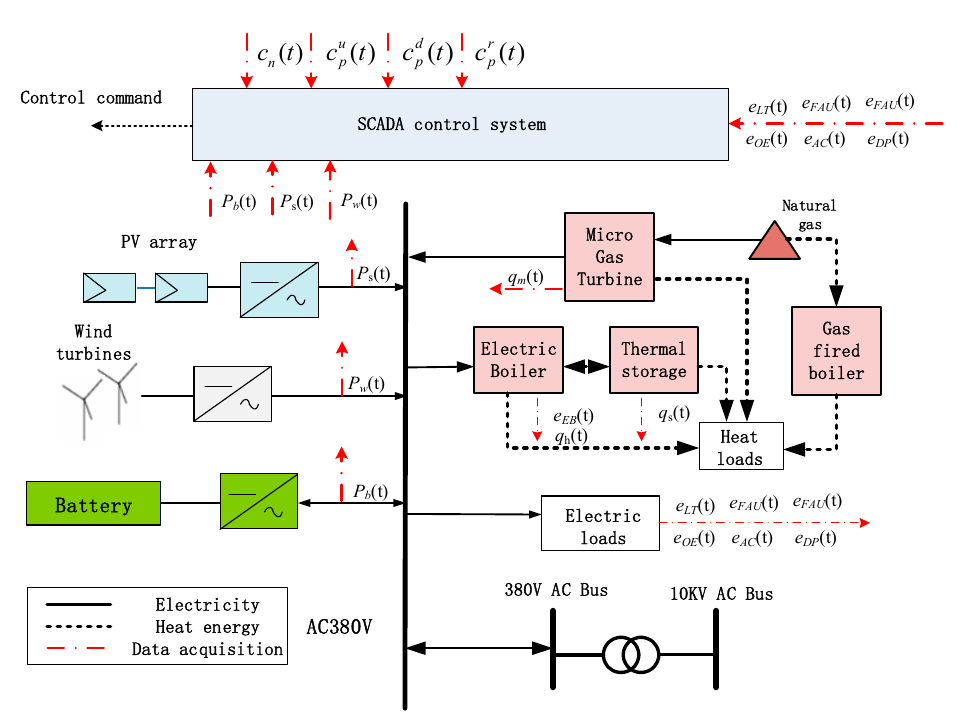
Figure 1. Multiple energy micro grid system model.